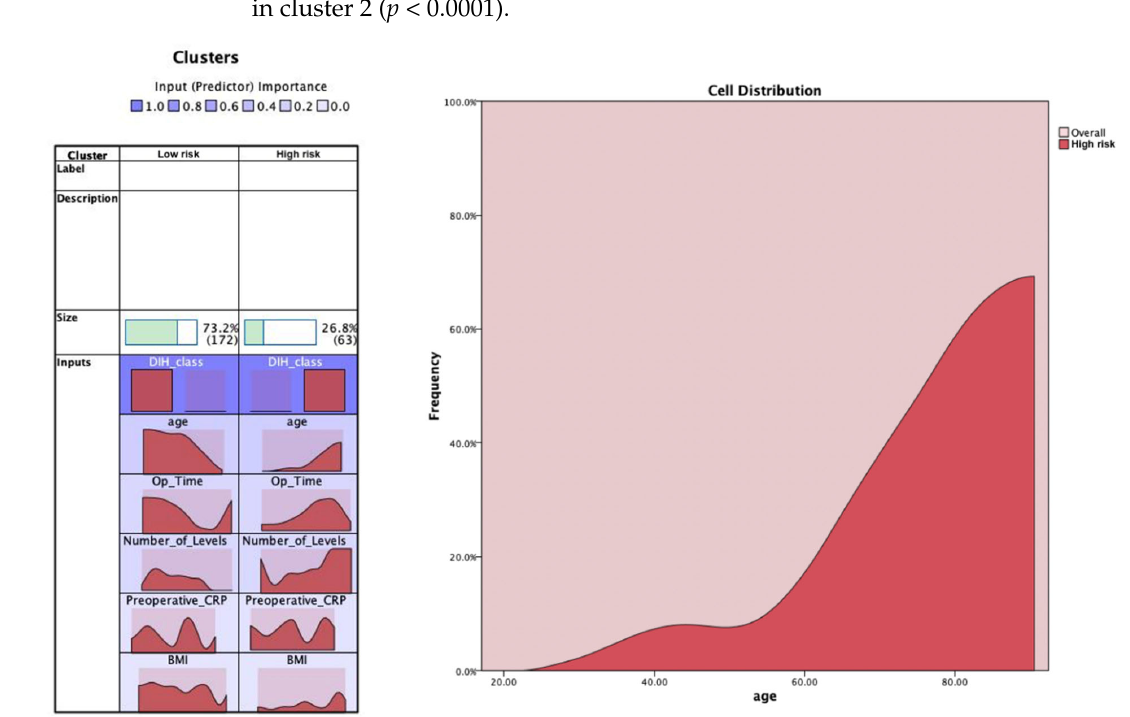
Figure 2. K-means cluster analysis for the binary hospital length of stay class (normal versus prolonged). The most important feature to classify the data was the hospital length of stay class (DIH_class), followed by age, operation time, number of levels, preoperative CRP, and BMI. The distribution charts show the distribution of the features for both clusters. An example feature (age) is shown to help interpretation. The selected feature shows that age distribution is right-shifted for the high risk cluster (including the prolonged hospital stay class), whereas it is left-shifted for the low risk cluster.